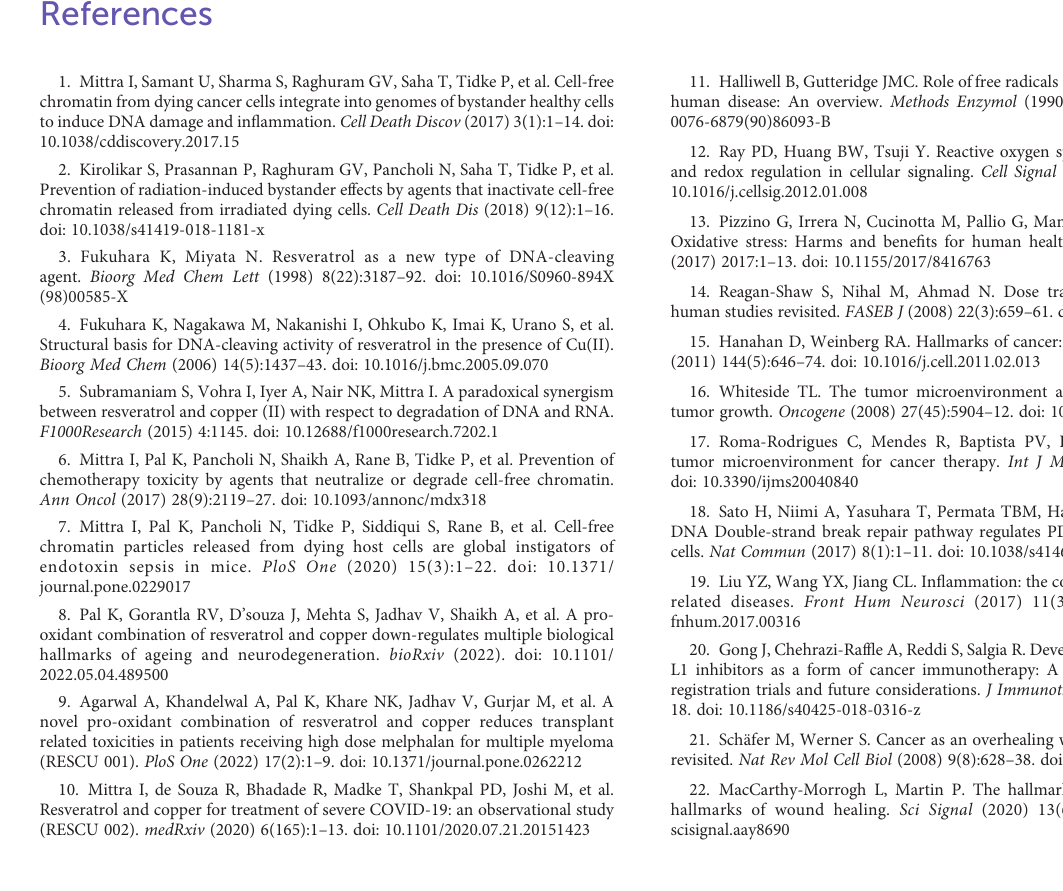
phenotype as seen on H&E section (B) . SUPPLEMENTARY FIGURE 2 Representative images showing expression of various immune checkpoint proteins by CD4 and CD8 lymphocytes. FFPE sections of OSCC tumour tissues were simultaneously immune-stained with antibodies against various immune-checkpoint proteins and those against CD4 and CD8 lymphocytes (scale bar 10µm). Co-localisation of all four immune check- point proteins and CD4 and CD8 lymphocytes is clearly